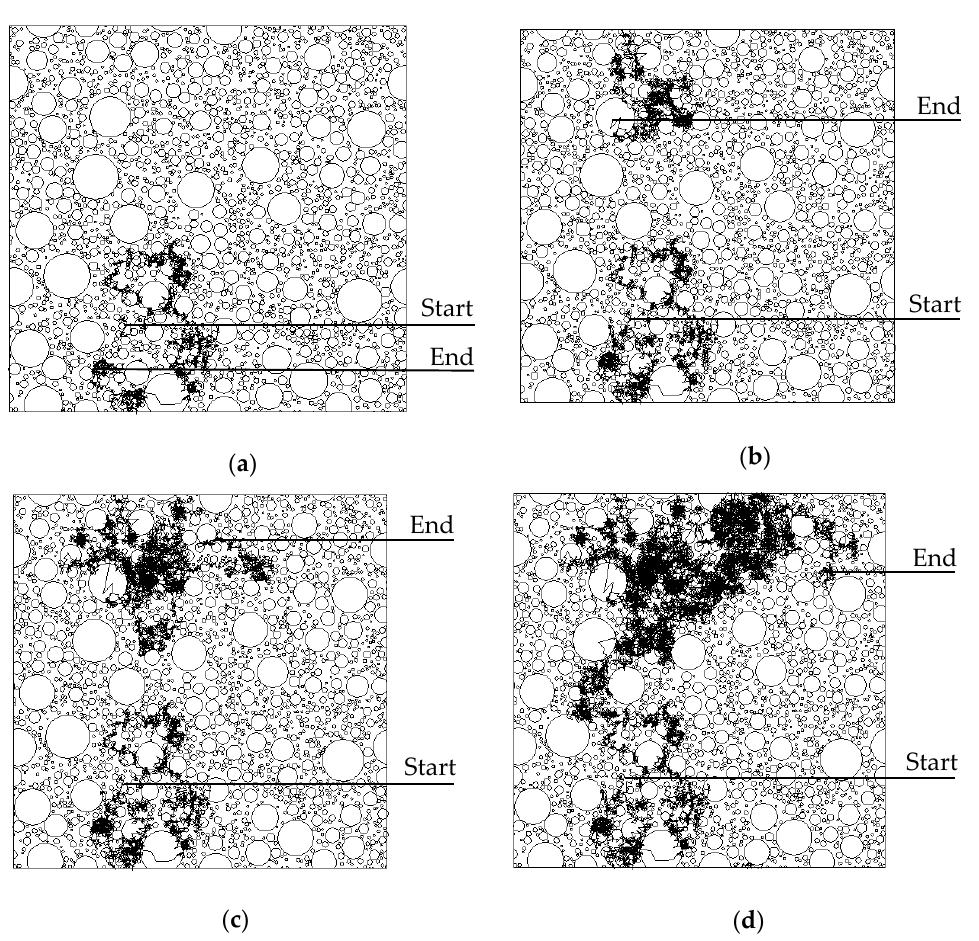
Figure 9. Random walk paths for ( a ) R 0 = 20 mm; ( b ) R 0 = 30 mm; ( c ) R 0 = 40 mm; and ( d ) R 0 = 60 mm.